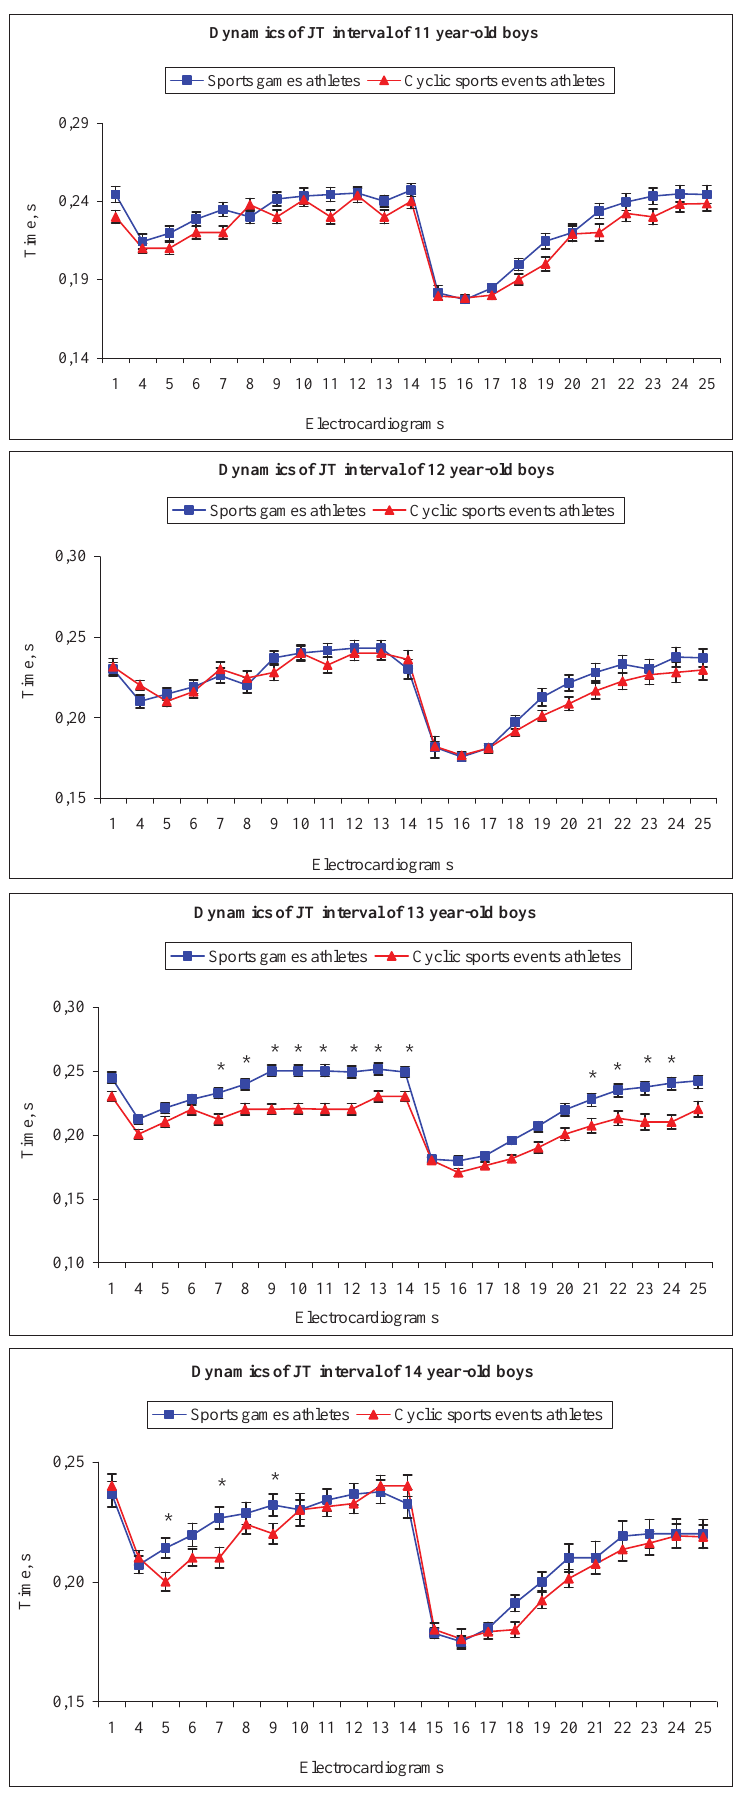
Fig. 3. Dynamics of JT interval while performing Roufi er test and 30 s maximal jumping test in various age groups of boys attending the training sessions in sports games and cyclic sports